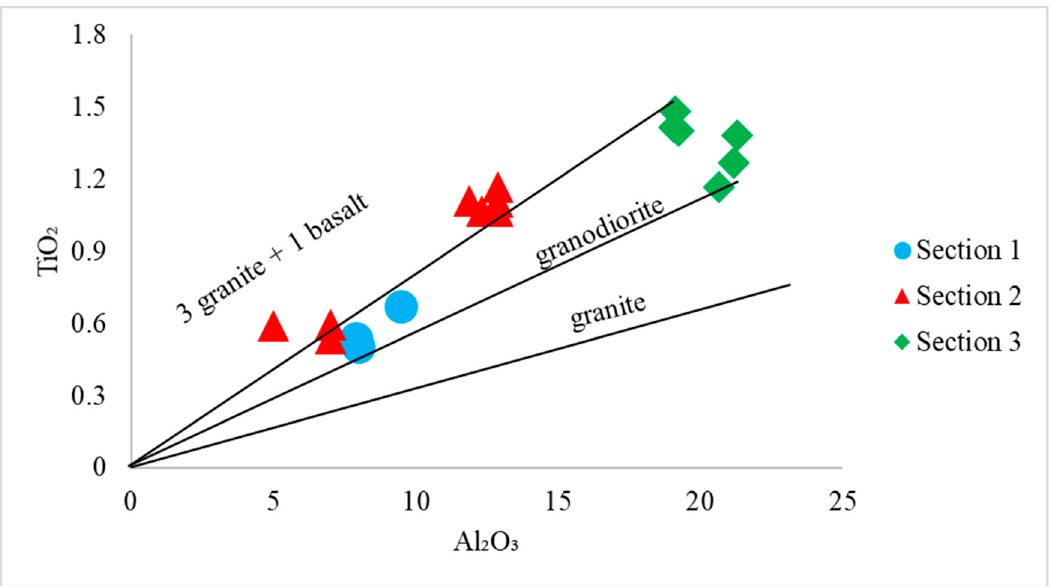
Figure 4. Plot of Al 2 O 3 versus TiO 2 plot for Chichali Formation shales.